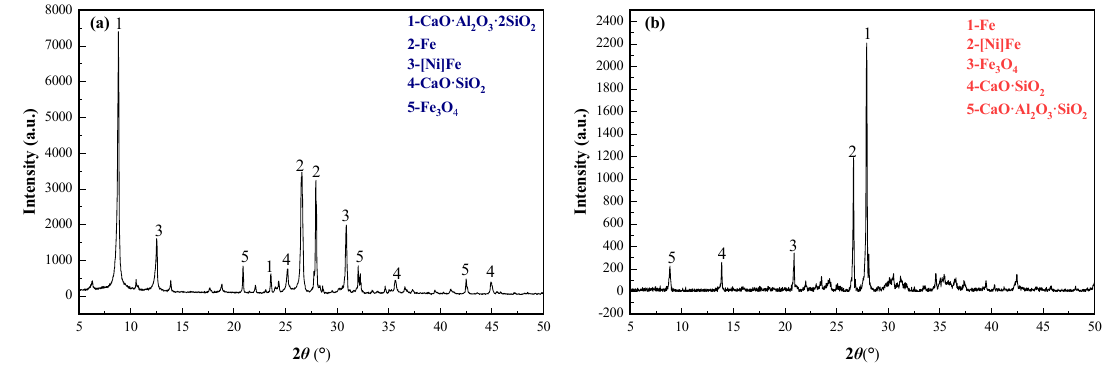
Figure 7. XRD diffractograms of the segregation roasting ores ( a ) and ferronickel ( b ). Figure 7. XRD di ff ractograms of the segregation roasting ores ( a ) and ferronickel ( b